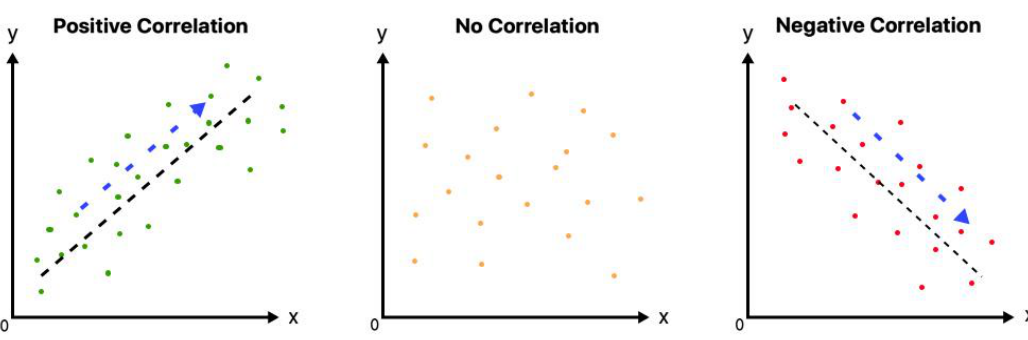
Figure 2. Linear correlation diagrams.